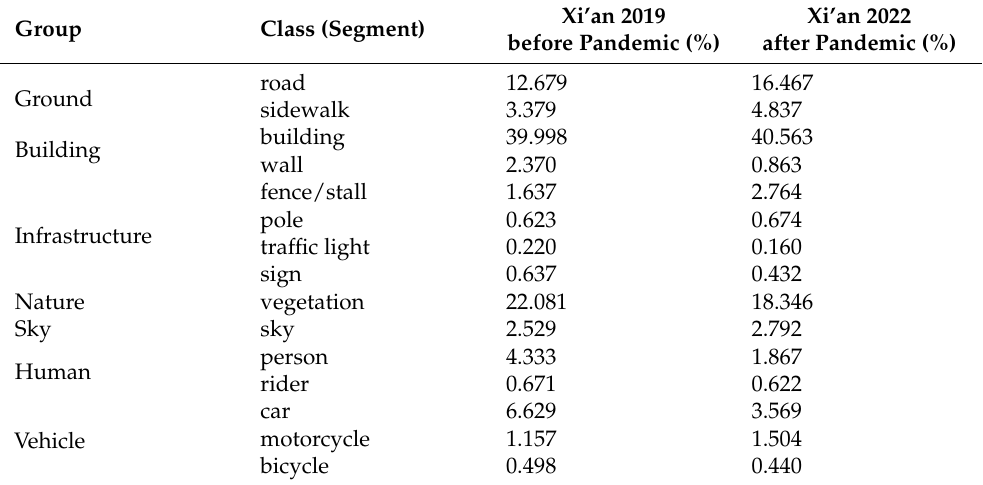
Table 3. Average value of PSG of each class for all points in Xi’an before and after COVID-19.